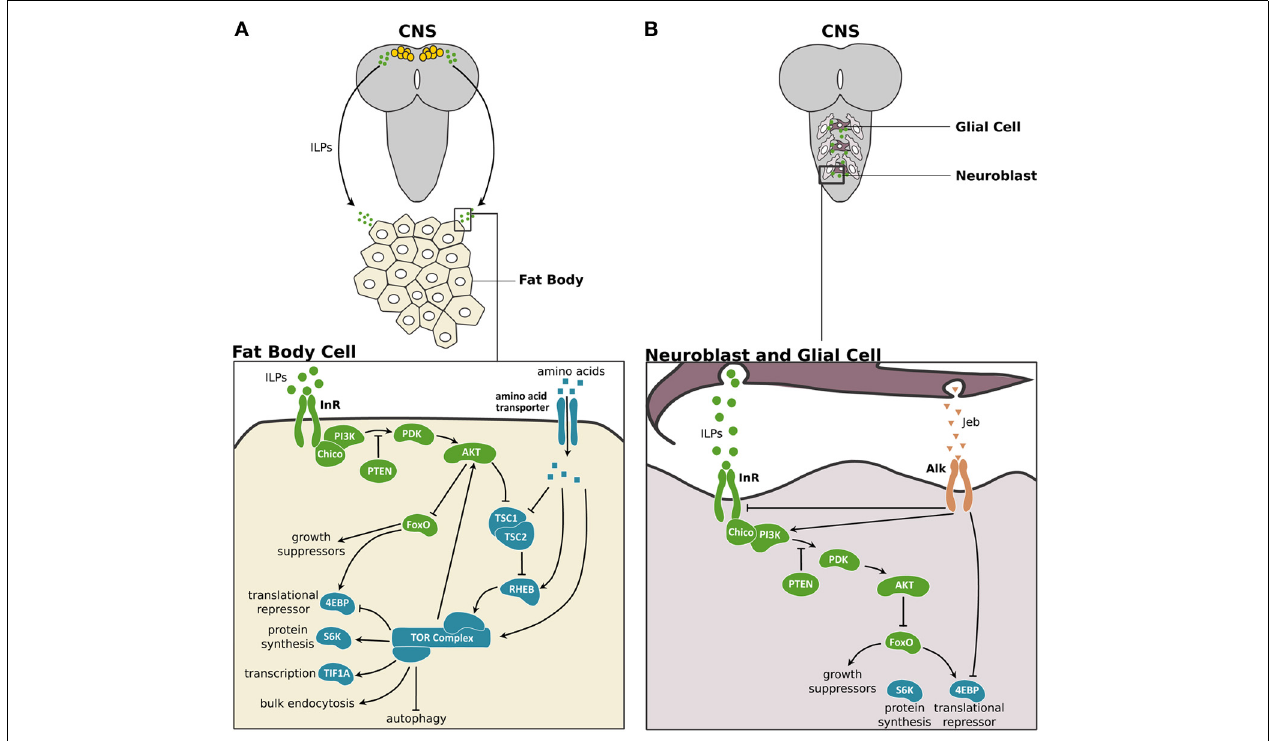
FIGURE 1 | The IIS/TOR signaling pathway in fat body and the central nervous system of Drosophila . (A) In Drosophila , three of the eight ILPs, ILP2, ILP3, and ILP5 are expressed in a set of neurosecretory cells in the central nervous system (CNS) (Brogiolo et al., 2001; Ikeya et al., 2002). These ILPs activate insulin/insulin-like growth factor signaling (IIS) in peripheral tissues like the fat body cells. In the fat body, the ILPs bind to and activate the Insulin Receptor (InR), which in turn activates Chico, the insulin receptor substrate. This activation initiates a phosphokinase signal transduction cascade that involves phosphatidylinositide 3-kinase (PI3K), the phosphoinositide-dependent protein kinase 1 (PDK) and the protein kinase Akt (Sarbassov et al., 2005). The phosphatase and tensin homolog (PTEN) catalysis the reverse reaction promoted by PI3K, thereby inhibiting the IIS pathway (Goberdhan et al., 1999; Gao et al., 2000). When activated, Akt promotes cell growth by inhibiting the transcription factor Forkhead Box class O (FoxO) (Junger et al., 2003), which activates the 4E-Binding Protein (4EBP), a translational repressor (Miron and Sonenberg, 2001). Furthermore, Akt suppresses the negative regulators of the Target of Rapamycin (TOR) pathway, Tuberous Sclerosis Complex 1 and 2